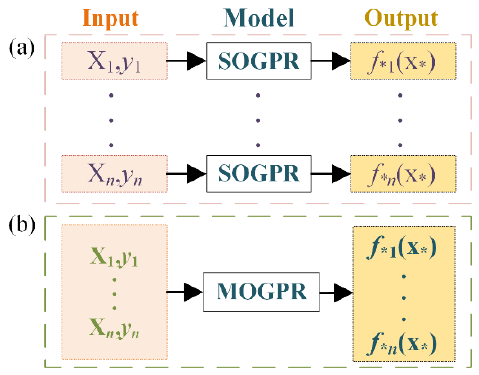
Figure 10. Basic principles of two GPR models: ( a ) basic principles of the SOGPR model; ( b ) basic principles of the MOGPR model.